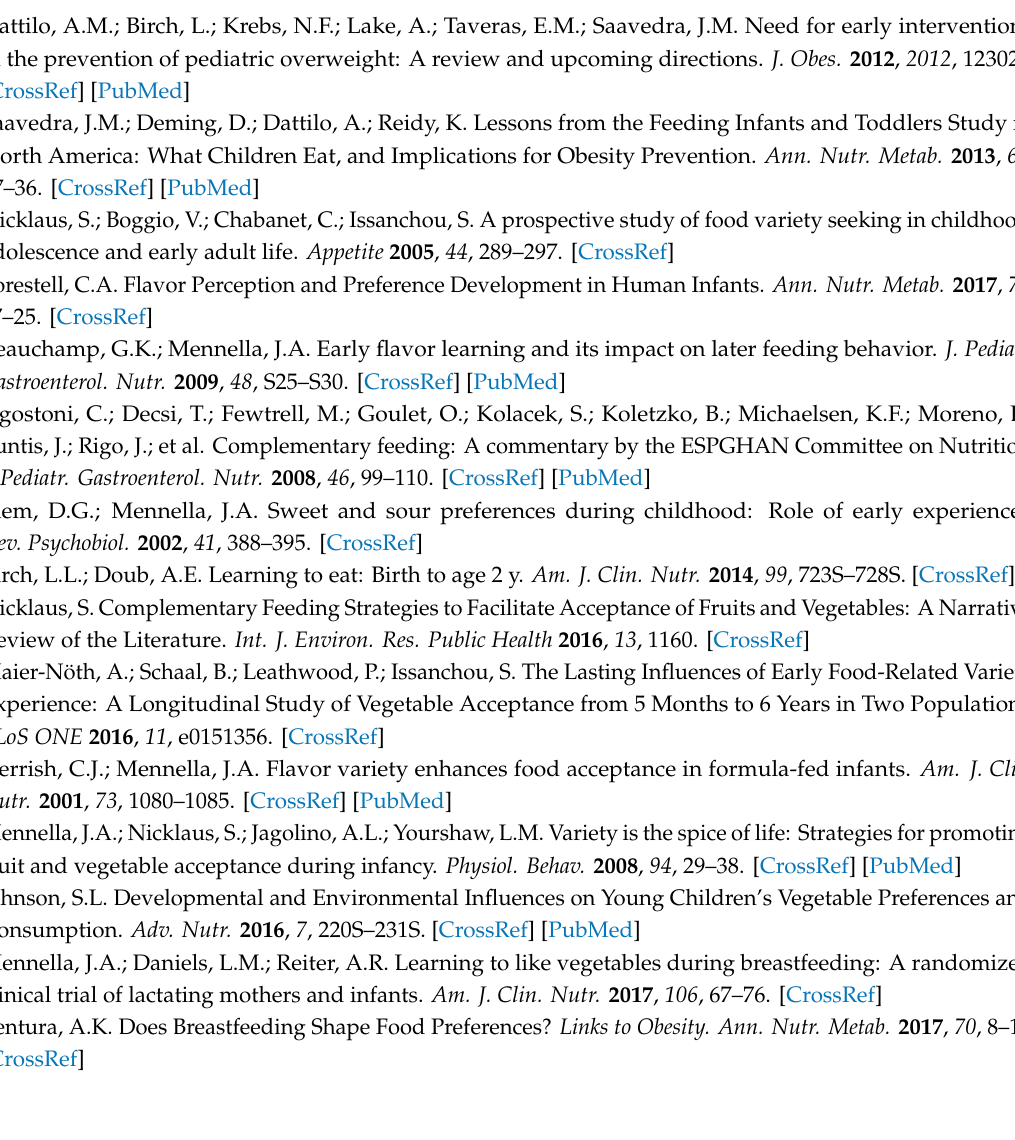
Table S1: Calculation of the Youth Healthy Eating Index (YHEI) score in Project Viva, Table S2: Indicator Variables for Latent Class Analysis, Table S3: Comparison of models with 2–5 classes for 1162 Project Viva Participants, TableS4: ComparisonofadjustedmeantotalYHEIscoresbetweenlatentclasses, stratifiedbysociodemographicand behavioral characteristics of Project Viva participants, Table S5: Average posterior probabilities for 4-class